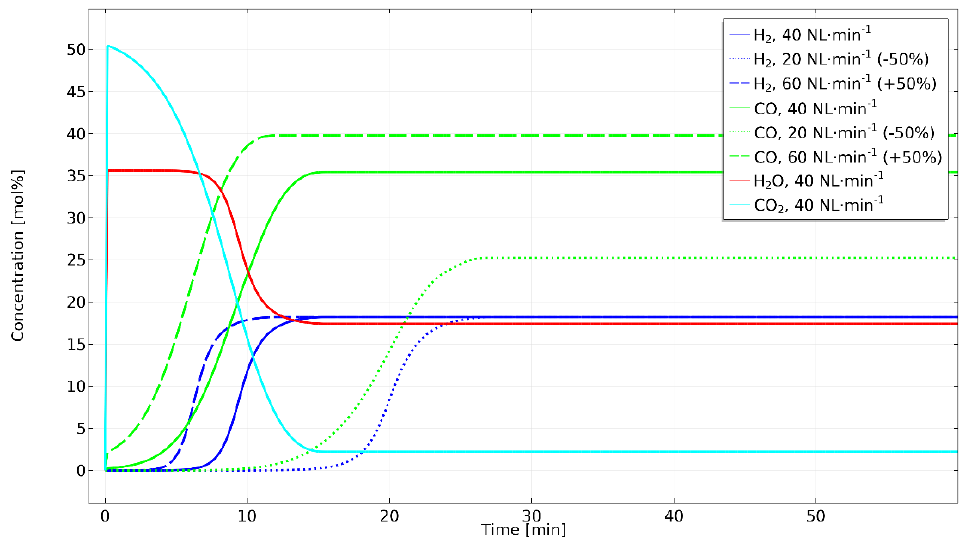
Figure 11. Model predicted breakthrough curves after iron-based OC reduction with syngas.